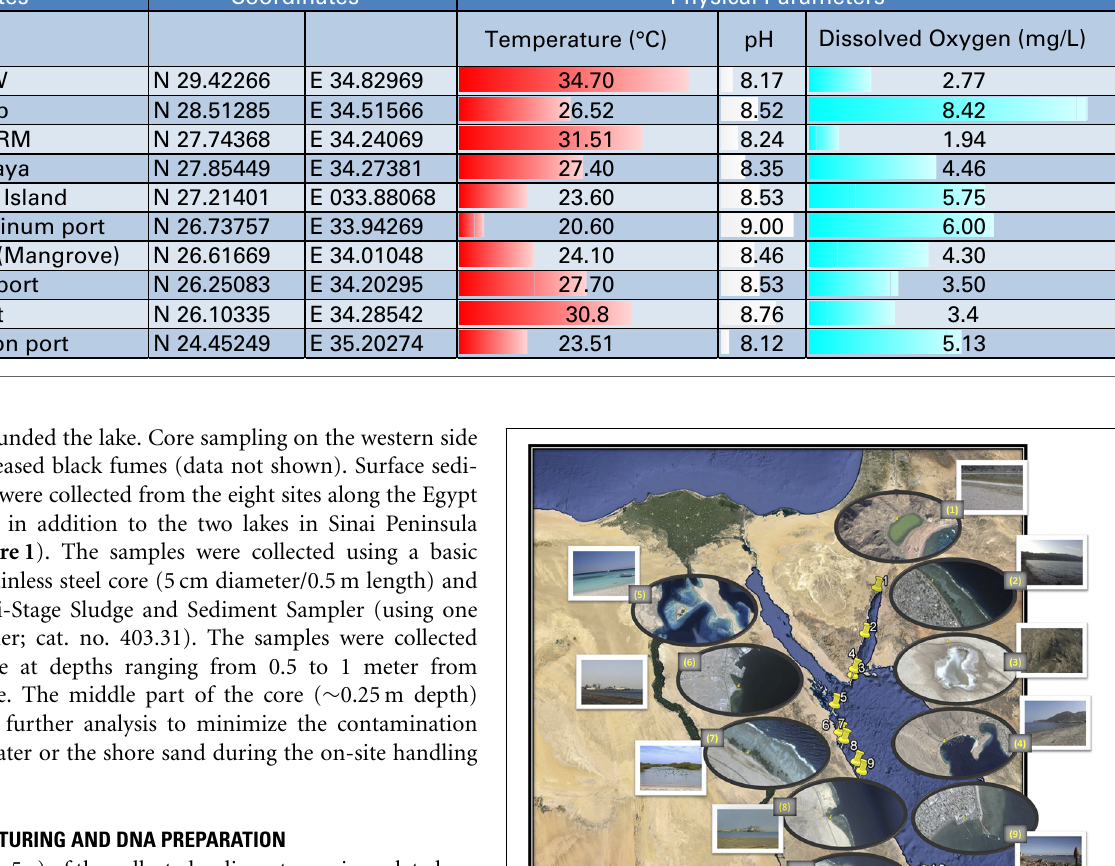
Table 1 | Samples, Sampling locations and Physical Parameters. S Sites Solar